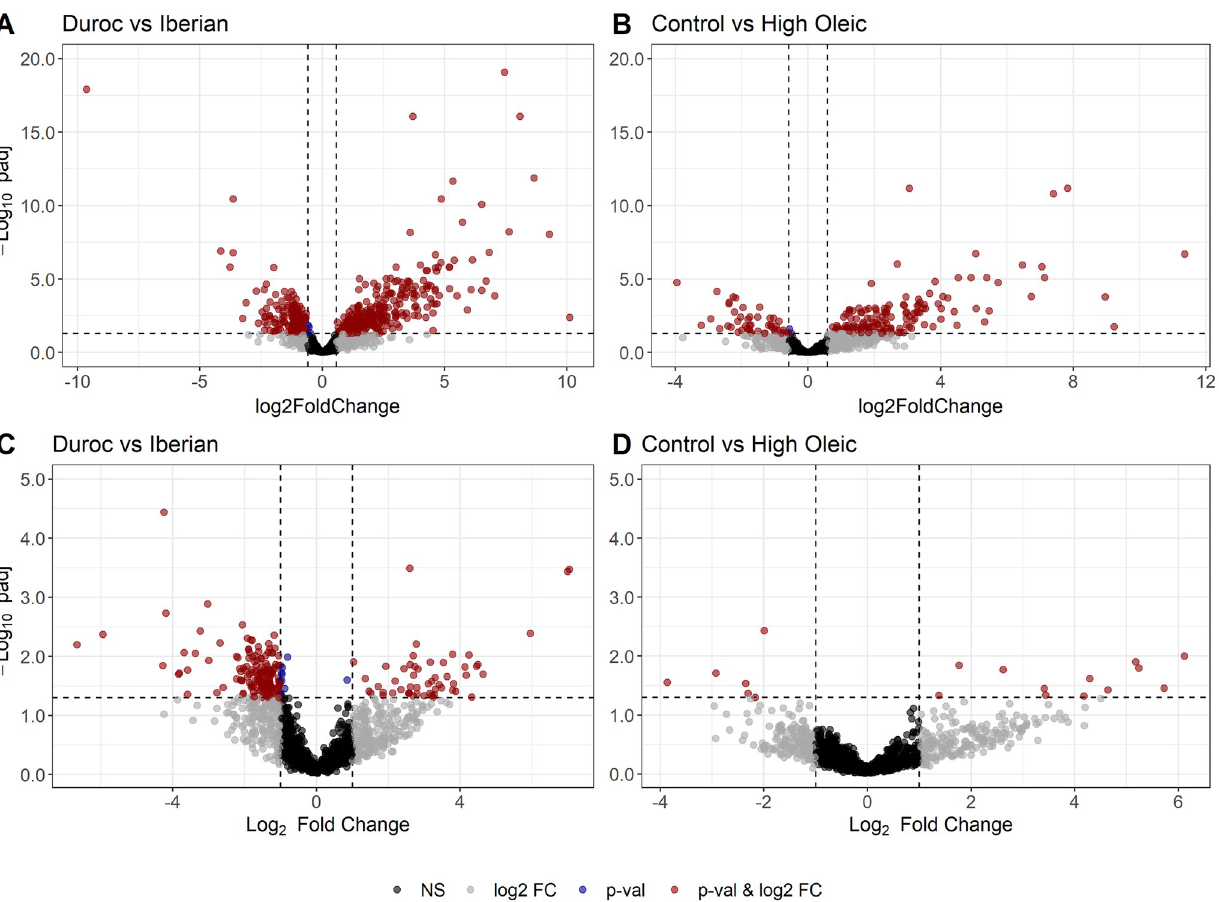
Fig 5. DA volcano plots. Volcano plots of differentially abundant OTUs using DESeq2 (A, B) and ALDEx2 (C, D), for breed (left) and diet (right) contrasts. Red dots represent OTUs with an adjusted p-value below the FDR cut-off (0.05) and a FC value above 1.5 or below -1.5 for DESeq2 contrasts, or a median difference between CLR values above 1 or below -1 for ALDEx2 contrasts. OTUs with Log2(FC) < 0 or diff.btw < 0 are more abundant in Duroc and Control groups, respectively.